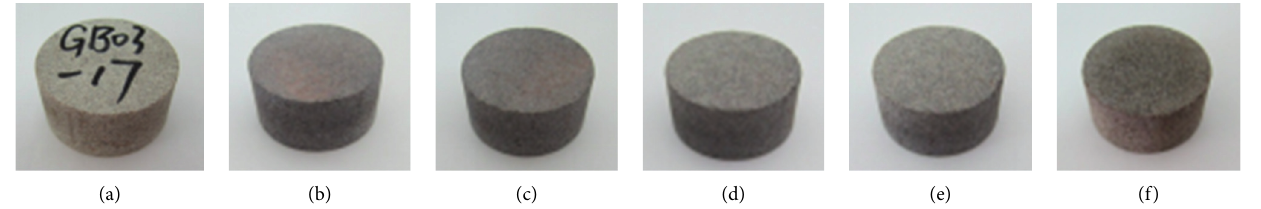
Figure 3: The apparent morphology of sandstone specimens after the action of cycles at 400 ° C. (a) 0 times. (b) 2 times. (c) 4 times. (d) 6 times. (e) 8 times. (f) 10 times.